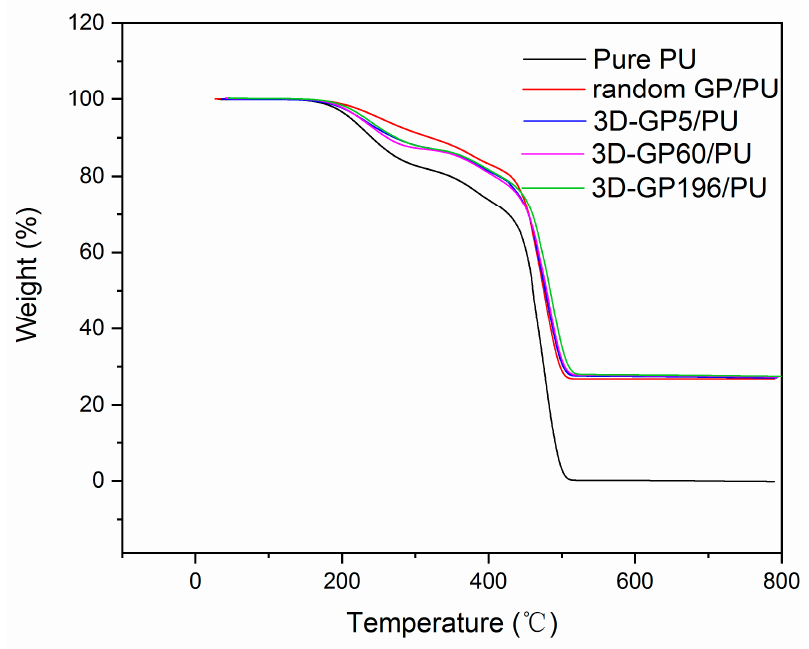
Figure 8. TGA curves of PU and composites.